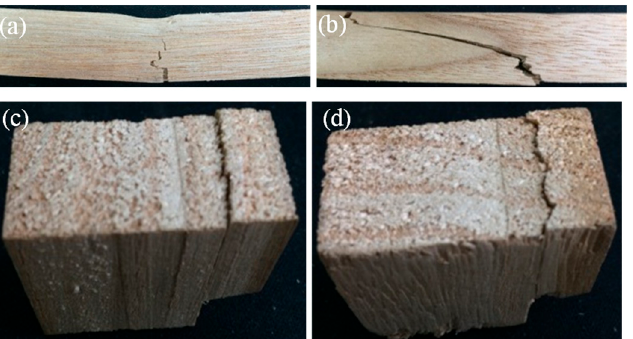
Figure 4. Typical failure modes: ( a ) bending crack in the bending specimen ( b ) shear crack in the bending specimen; ( c ) straight crack in the tangential shear specimen; ( d ) wave-form crack in the radial shear specimen.